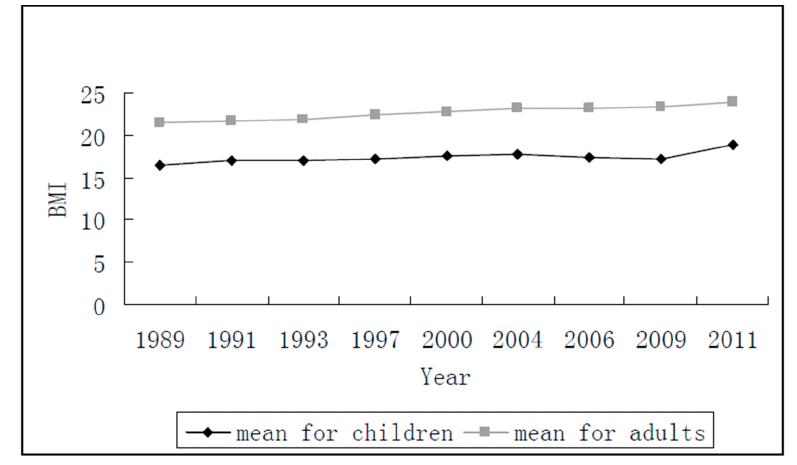
Figure 2. Body Mass Index (BMI) over time. Table 1. Means of six variables for Granger causality test over time.